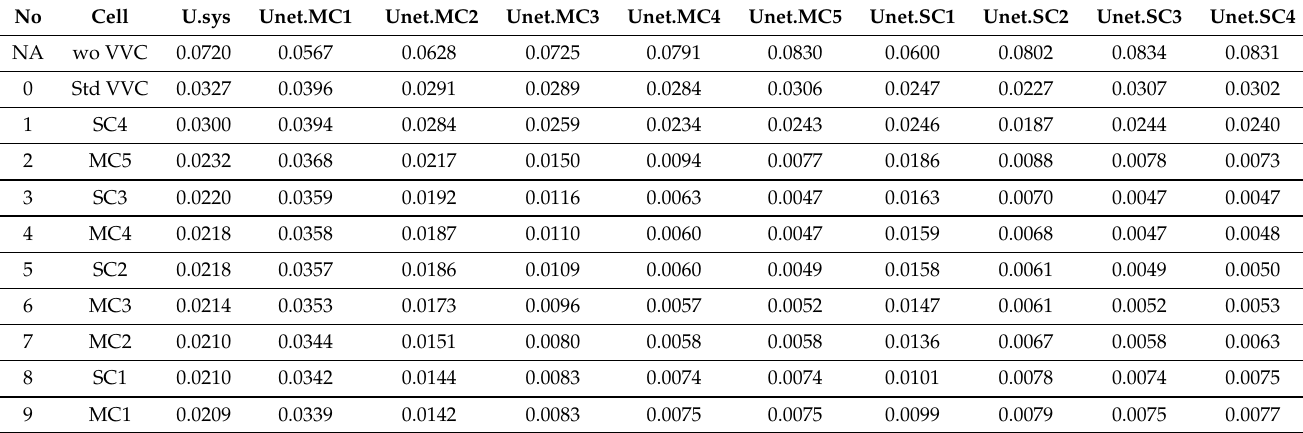
Table A3. Sequentially optimized utility